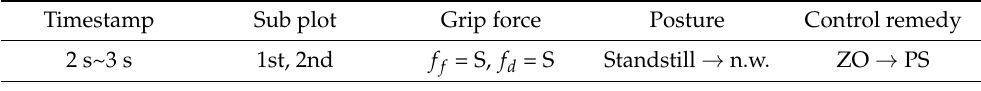
Table 12. Summary of experimental results (Uphill v = ZO, S g = PS). Timestamp Sub